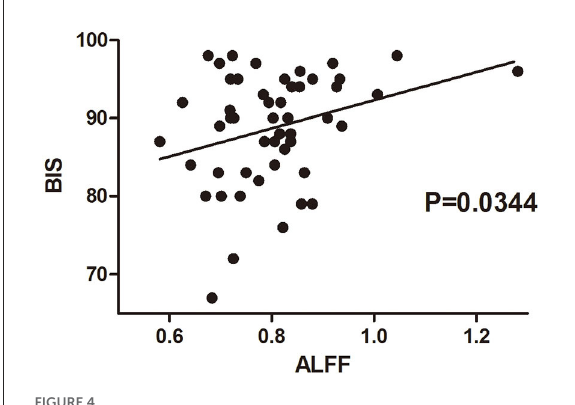
FIGURE4 Correlation between BIS and ALFF values of the thalamus in healthy volunteers of both groups before and after the intervention. The correlation between BIS values at the beginning and by the end of the intervention in each volunteer was evaluated with their averaged ALFF values from the fMRI scan before and after the intervention. There was a significantly positive correlation between the average ALFF values of the thalamus and BIS values. BIS, bispectral index; ALFF, amplitude of low-frequency